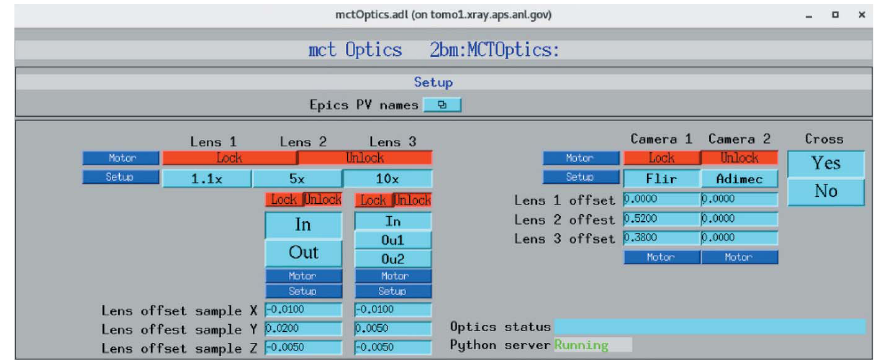
and can be corrected